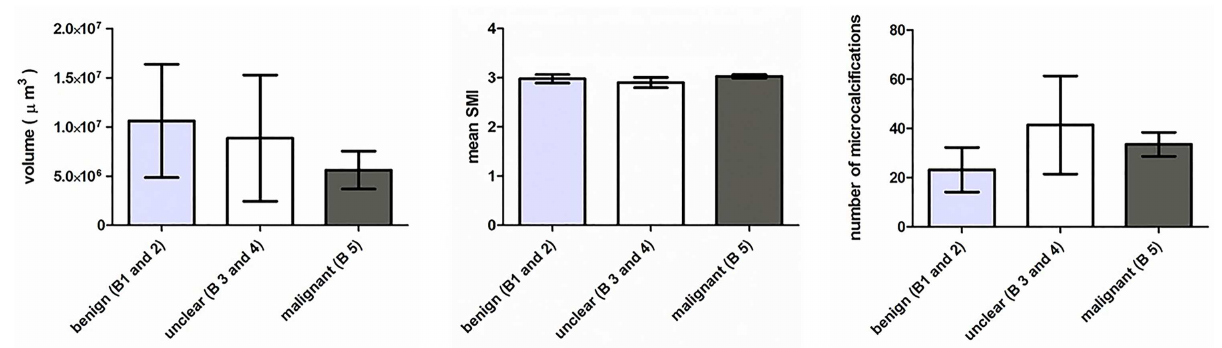
Fig 1. Overview of different morphological parameters including mean number, volume ( μ m 3 ) and SMI of MC for all different groups (benign: including B-classification B1 and B2; unclear malignant potential: including B-classification B3 and B4; malignant lesions: including B-classification B5). Error bars indicate the standarderror of the mean (SEM).